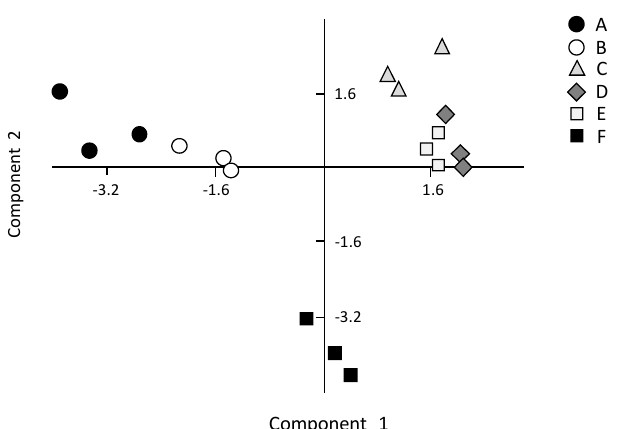
Figure 5. Principal component analysis (PCA) of sediment variables, including sand, silt, and clay content, median particle diameter (Md), and water and total organic carbon content. PC1 = 67.6% of variance, PC2 = 23.9% of variance. Table 3. Component correlation coefficients in the principal component analysis (PCA) of the sediment variables and the first two components (PC1 and PC2 = 67.6% and 23.9% of variance, respectively).